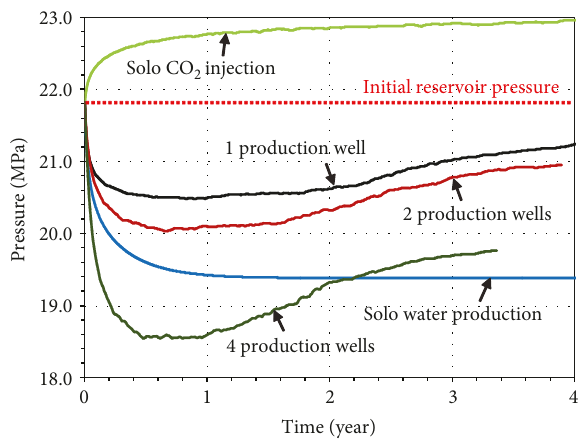
Figure 15: The pressure evolution curve at the monitoring point under di ff erent numbers of production well